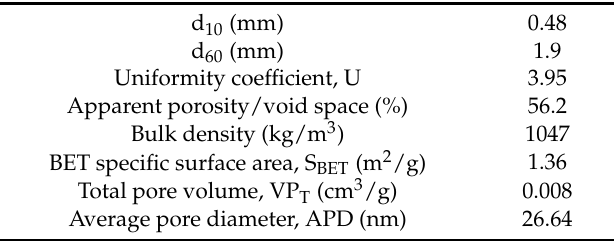
Table 1. Structural and textural characteristics of ground tezontle